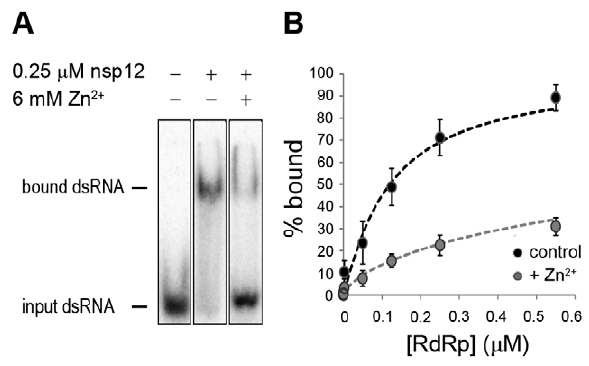
Figure 8. The effect of Zn 2 + on SARS-CoV nsp12 template binding. ( A ) Electrophoretic mobility shift assay with radiolabeled dsRNA and nsp12 in the presence and absence of Zn 2 + (indicated above the lanes). The position of unbound and nsp12-bound RNA in the gel is marked on the left of the panel. ( B ) Determination of the nsp12 affinity for RNA in the presence and absence of Zn 2 + . A fixed amount of RNA was incubated with an increasing amount of nsp12. This revealed a 3–4 fold reduction in the percentage of bound RNA in the presence of zinc ions (grey) relative to the percentage of bound RNA in the absence of zinc ions (black). Error bars represent standard error of the mean